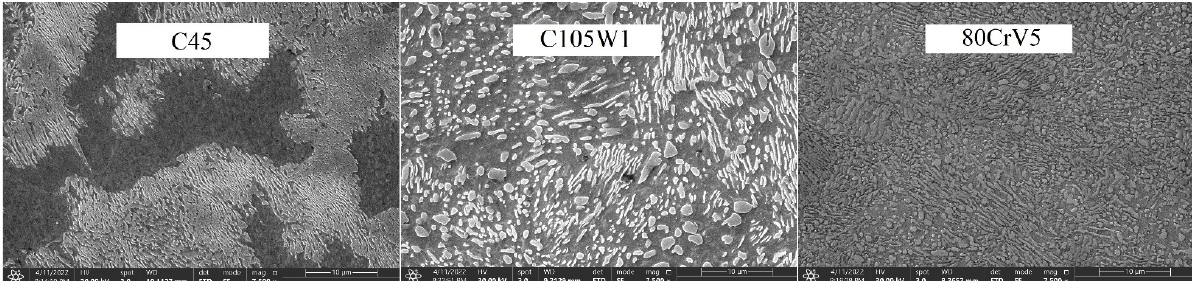
Figure 1. Natural states of the used